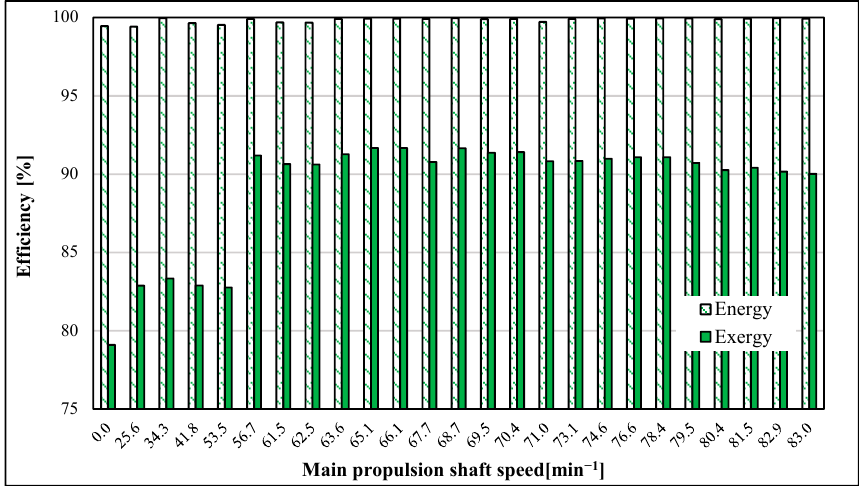
Figure 5. Exergy flow of atmospheric drain tank with main turbine load variation.